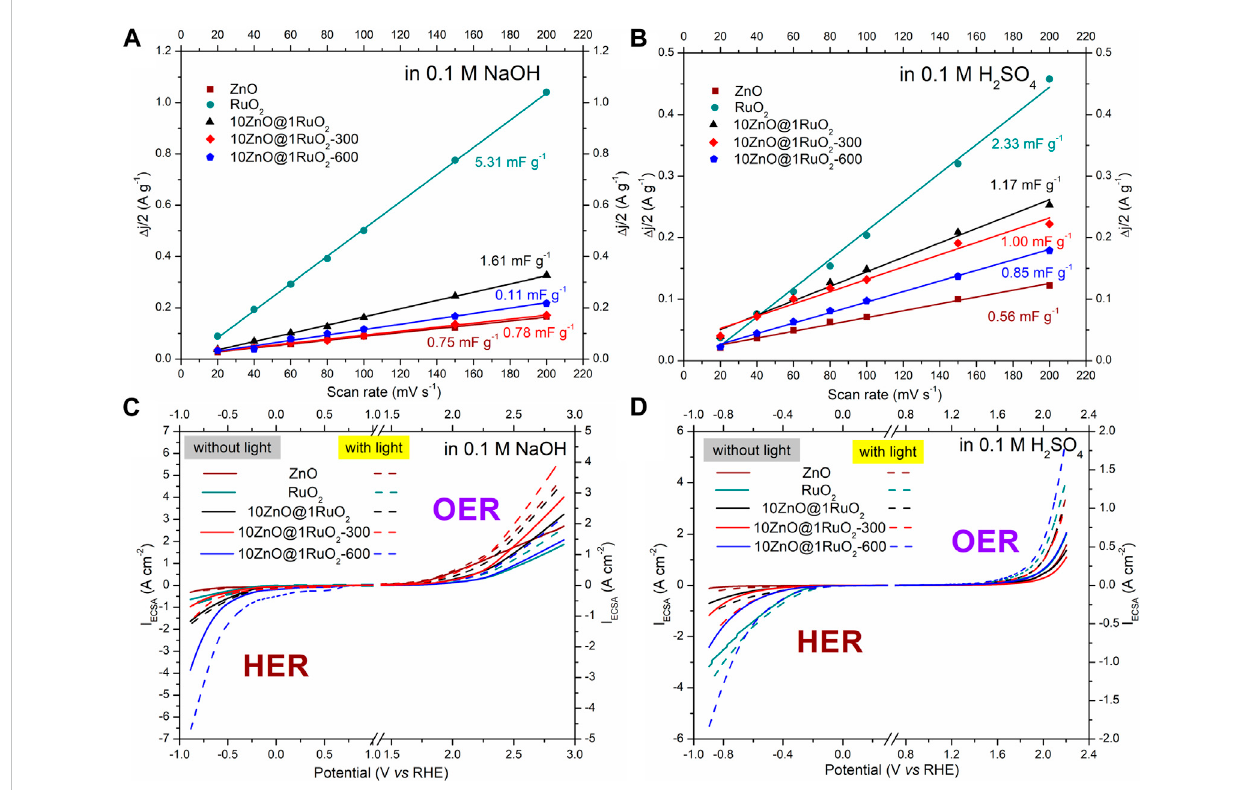
FIGURE 10 Calculateddouble-layercapacitance(Cdl)usedtoestimatetheelectrochemicallyactivesurfaceareaofthesamplesin (A) 0.1 MNaOHand (B) 0.1